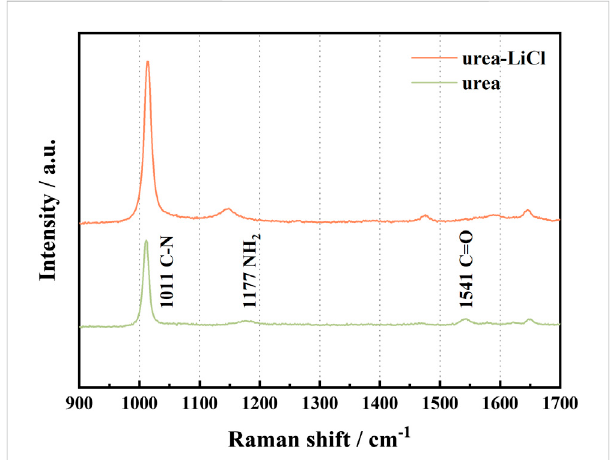
Raman spectra before and after adding LiCl in